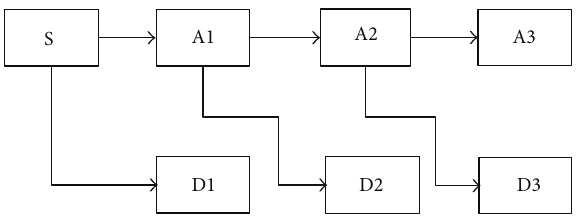
Figure 4: Multilevel decomposition process.